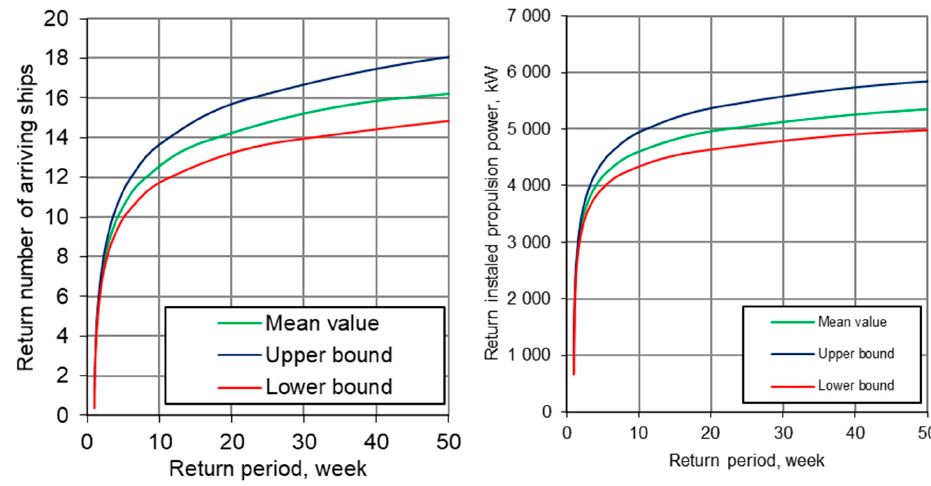
Figure 10. Return period of arriving ships ( left ) and installed engine power ( right ).